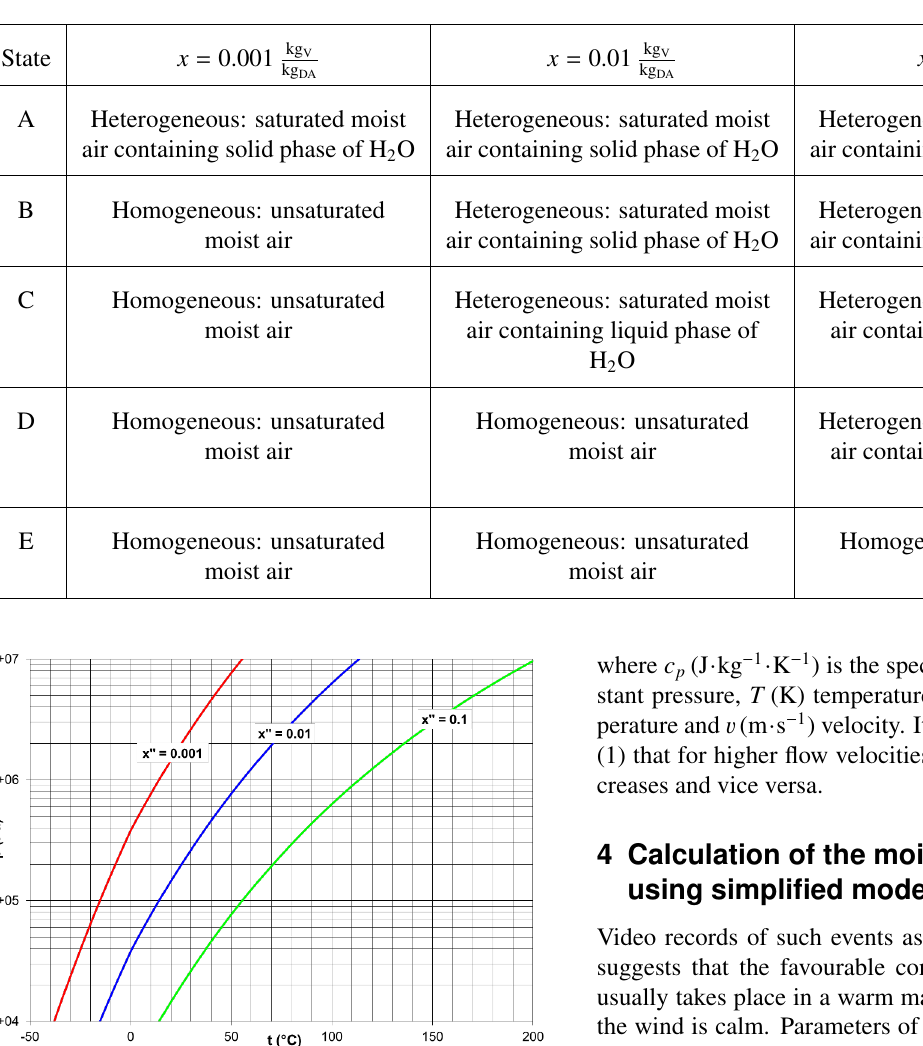
Table 1. Quality of the selected states of the moist air for three di ff erent values of the specific humidity x (see Figure 3) .